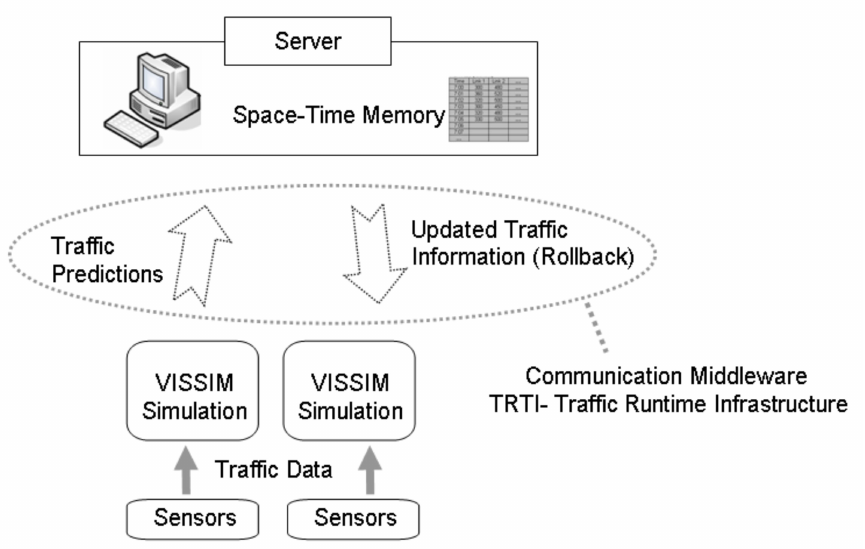
Figure 1. System